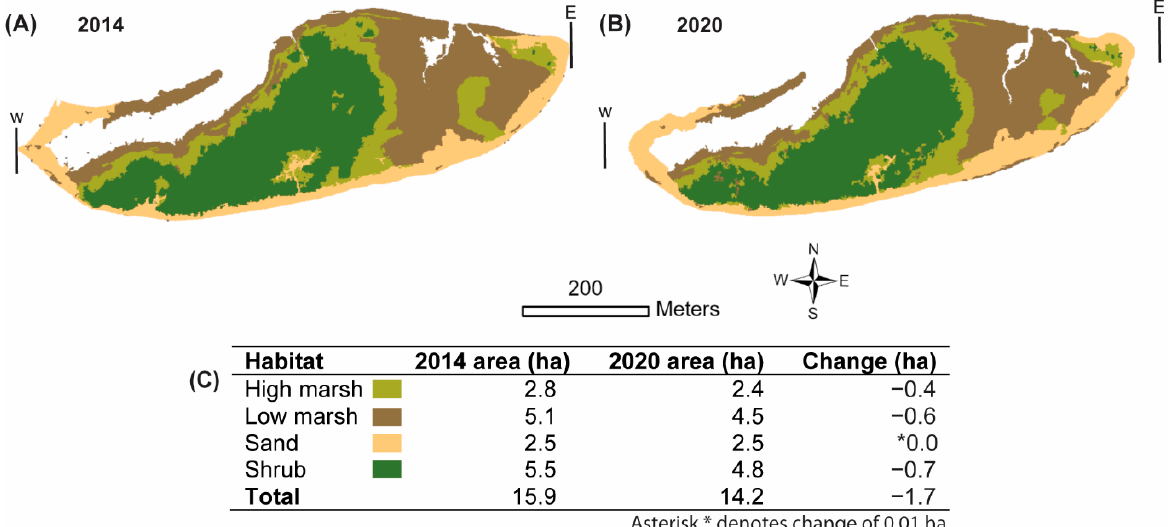
Figure 2. ( A ) 2014 habitat map, ( B ) 2020 habitat map, and ( C ) table showing the percentage of habitat decrease from 2014 to 2020. In the habitat maps, a color scheme was chosen where high marsh was assigned olive green, low marsh was leather brown, sand was medium sand, and shrub was spruce green.